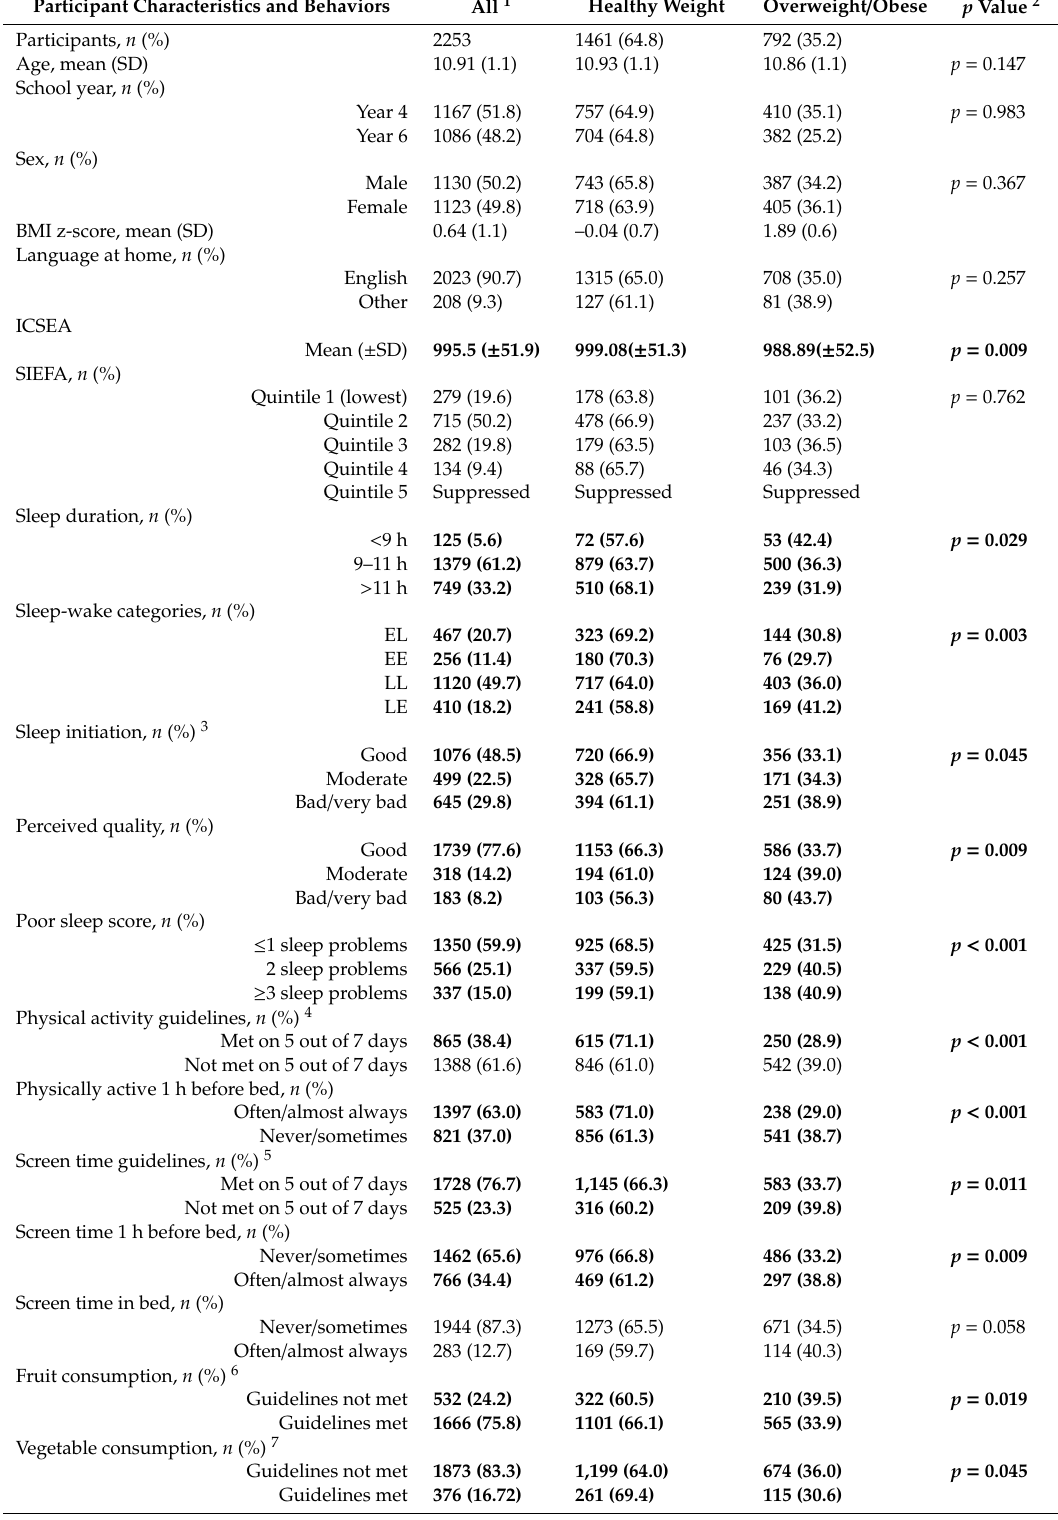
Table 1. Participant demographic characteristics and behaviors by weight